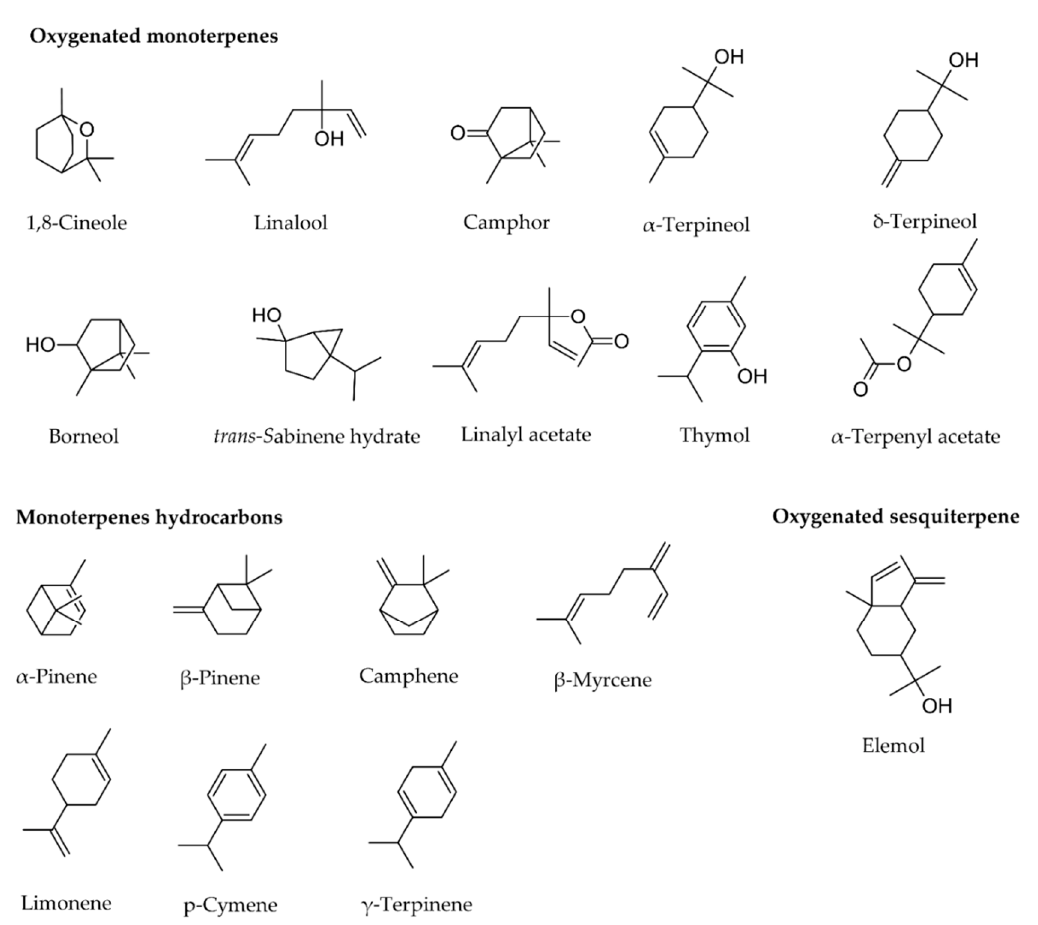
Figure 2. Chemical structures of main constituents of the Thymus mastichina essential oil categorized in oxygenated and hydrocarbons monoterpenes and hydrocarbon sesquiterpene.